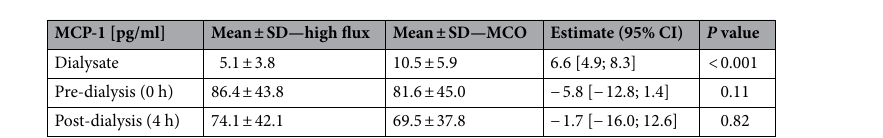
Table 2. Primary endpoint analysis. The impact of treatment (MCO = 0) on the primary endpoint MCP-1 serum levels was estimated using a linear mixed effects model, with subject ID, nested in sequence as a random effect and treatment (MCO = 1), period and sequence as the main effects. No significant carry over effect was seen for the reported variables. Mean and standard deviation (SD) values for MCP-1 dialysate, pre- or post- dialysis- serum levels were calculated from T1 and T3 stratified by treatment (ITT population). For LMM and paired t-tests a P value of < 0.05 was considered statistically significant.